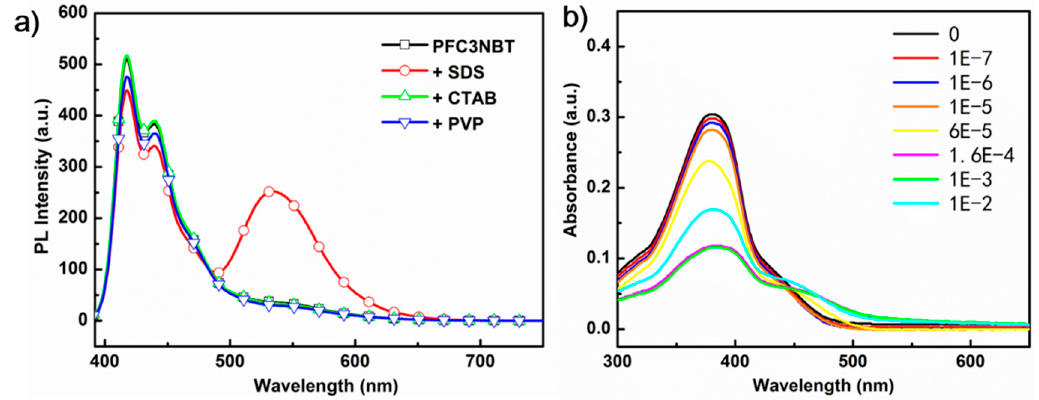
Figure 2. ( a ) PL spectra of PFC3NBT in the absence and presence of surfactant of SDS, CTAB, PVP ((RU) = 4.5 μ M, [surfactant] = 5 μ M, excitation at 380 nm); ( b ) UV-Vis spetra of PFC3NBT ([RU] = 4.5 μ M) in the absence and presence of SDS with the concentration ranging from 0 to 20 mM.